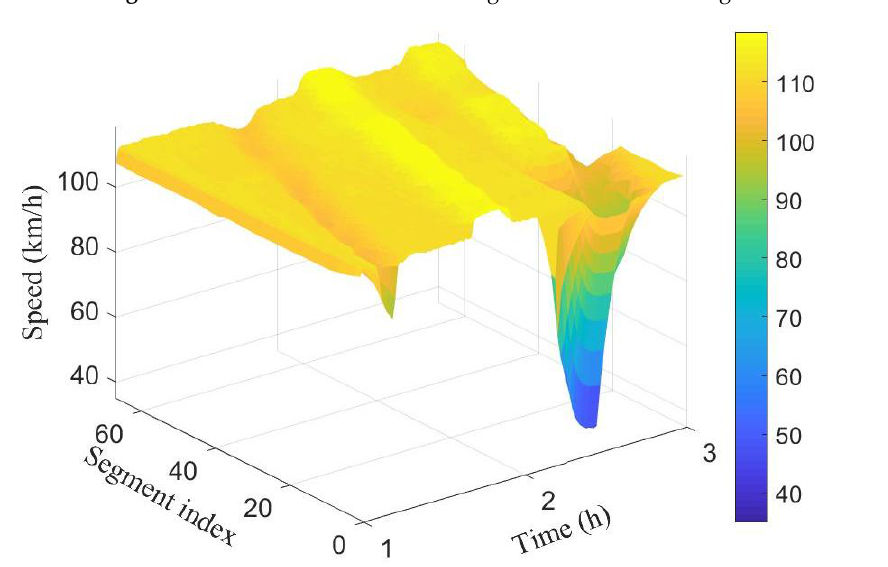
Figure 7. Estimated flow for the 100 segment with 30% missing data.